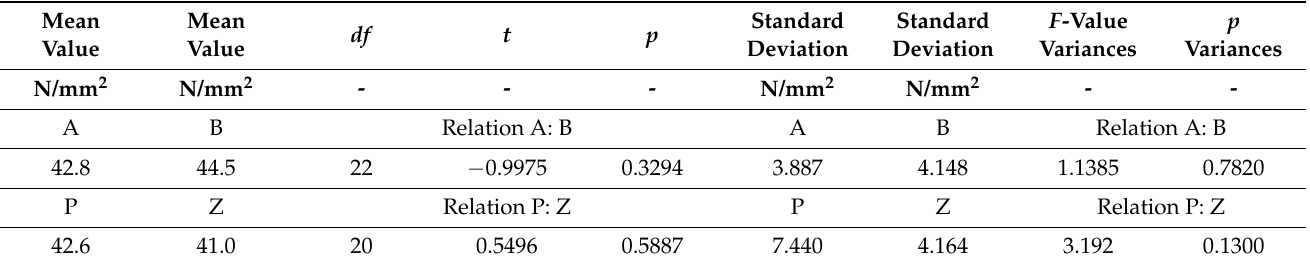
Table 4. Statistical analysis of changes in bending